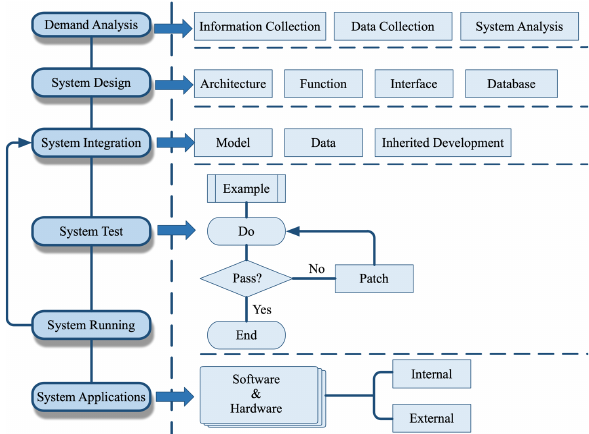
Figure 2 . Flowchart of research and development.